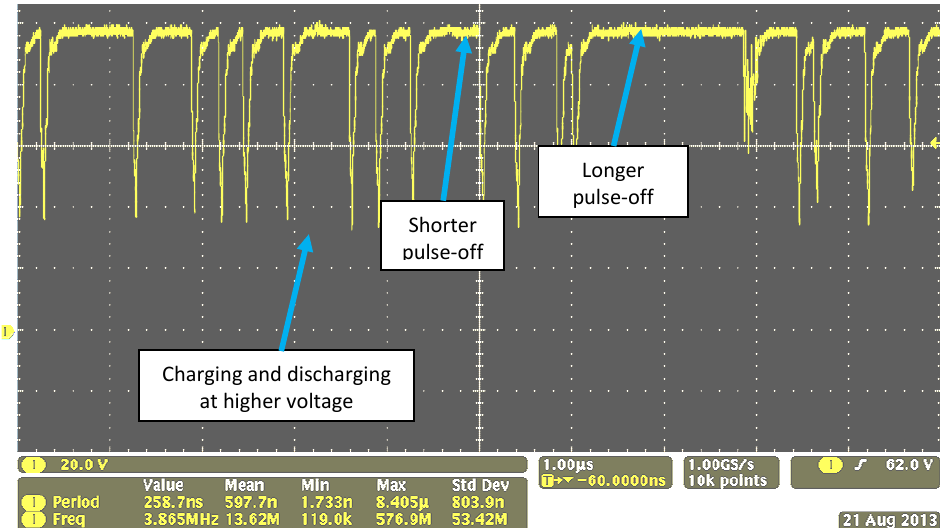
Figure 7: Effective arc discharge at C = 100 pF and V = 100